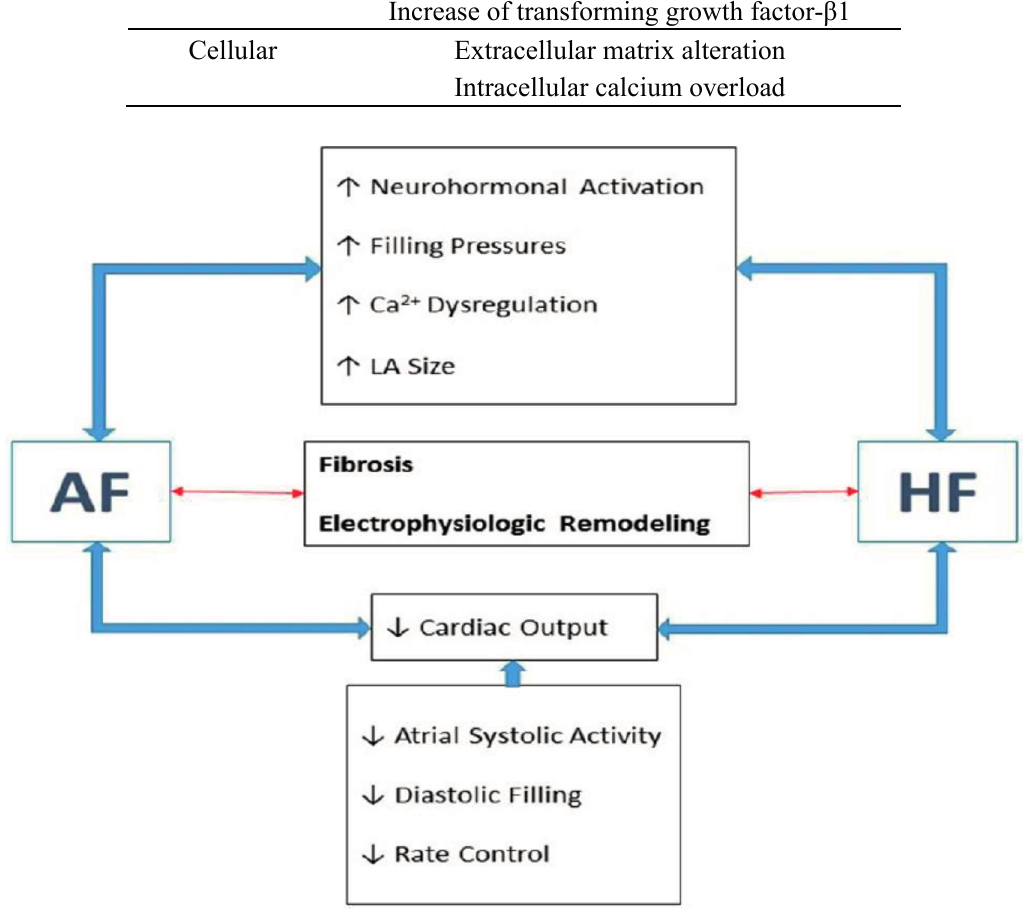
Figure 1. Common pathophysiological background for heart failure (HF) and atrial fibrillation (AF). LA: left